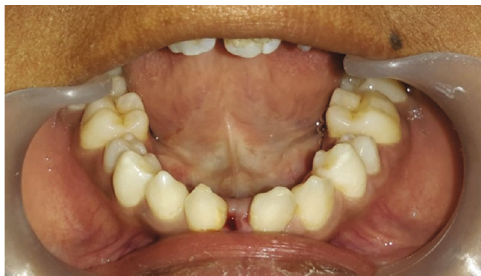
Figure 6: Lower arch “ Kesling diagnostic setup.